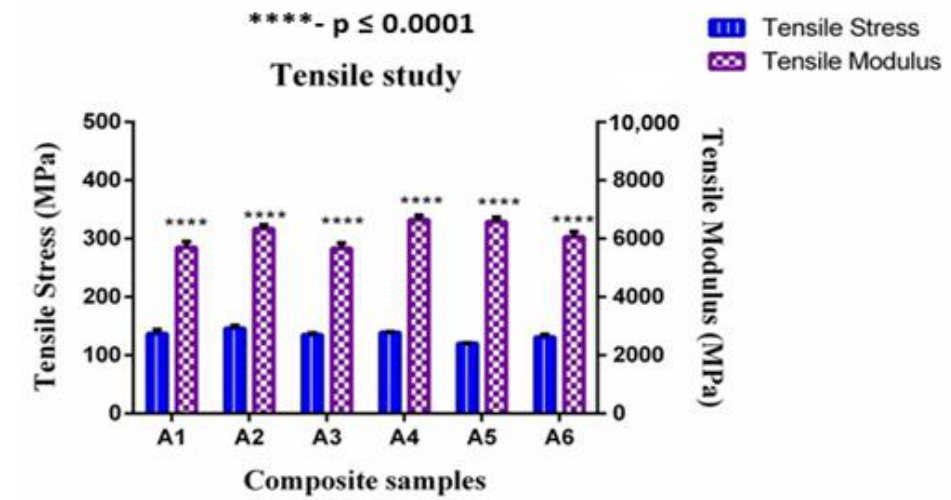
Figure 3. Tensile modulus vs. tensile strength of GF / SF / CTS composite sca ff olds. Data are represented as means of triplicate (n = 3) ± SD, where **** indicates p ≤